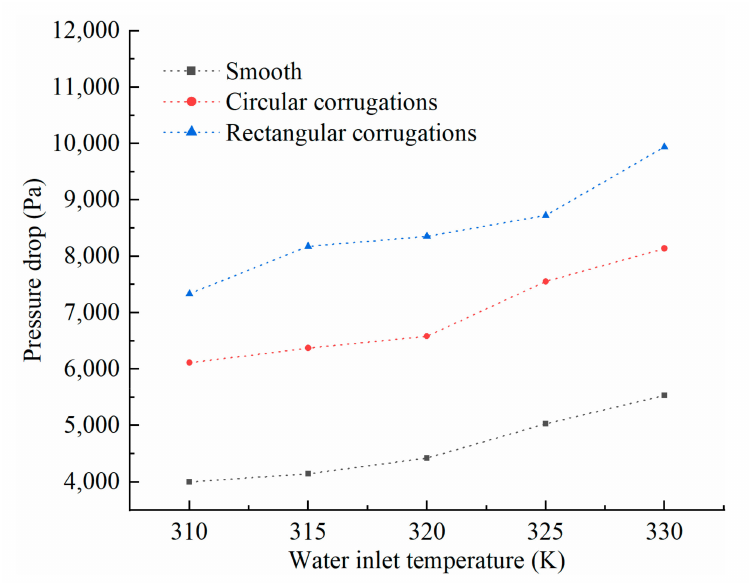
Figure 11. Impact of water inlet temperature on the total pressure drop for all